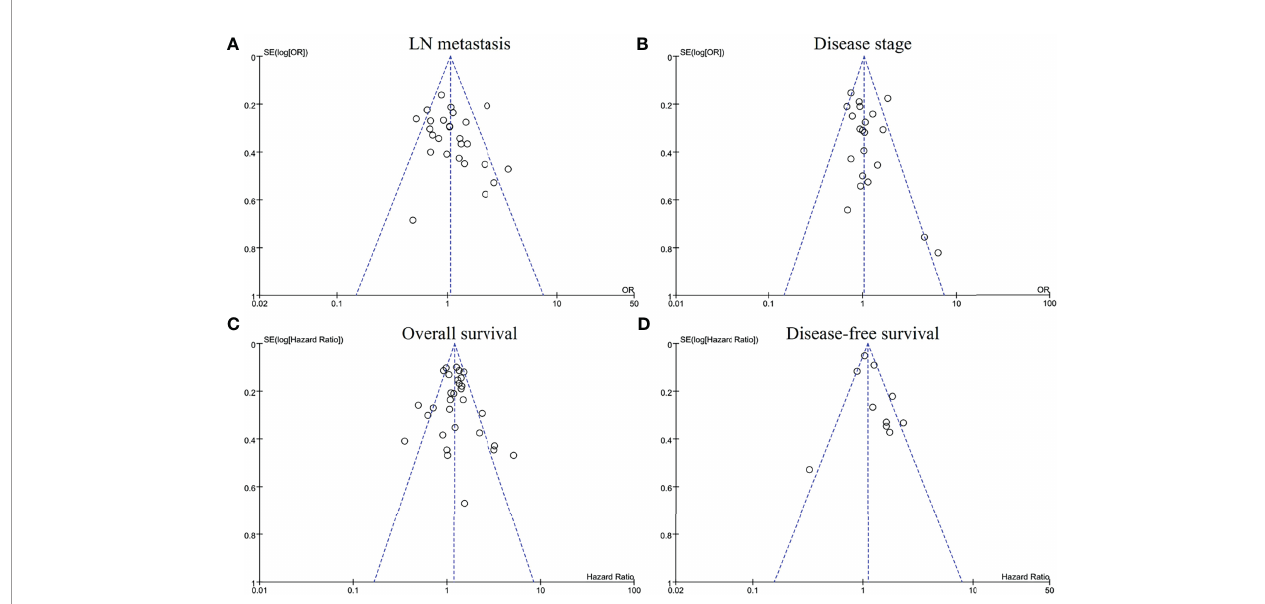
FIGURE 6 | Funnel plots for publication bias regarding lymph node metastasis (A) , disease stage (B) , overall survival (C) , and disease-free survival (D)